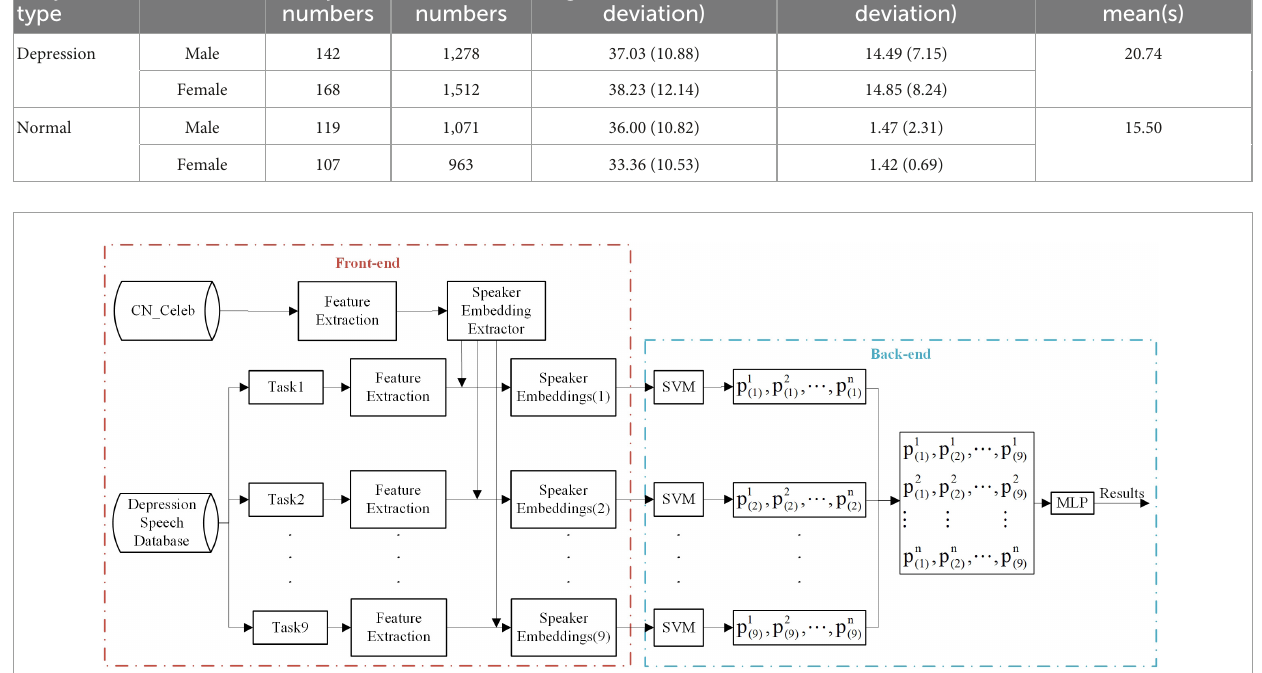
FIGURE1 General methodology diagram of the proposed depression detection system. The acoustic feature could be MFCC, PLP, or FBANK. The speaker embedding extractor type can be i-vector, TDNN x-vector, and Resnet x-vector, and the speaker embedding type is derived from the extractor type. n represents the number of training subjects. The subjects are divided into 10 folds according to the 10-fold cross-validation rule, in which nine folds are used for training and onefold for testing.